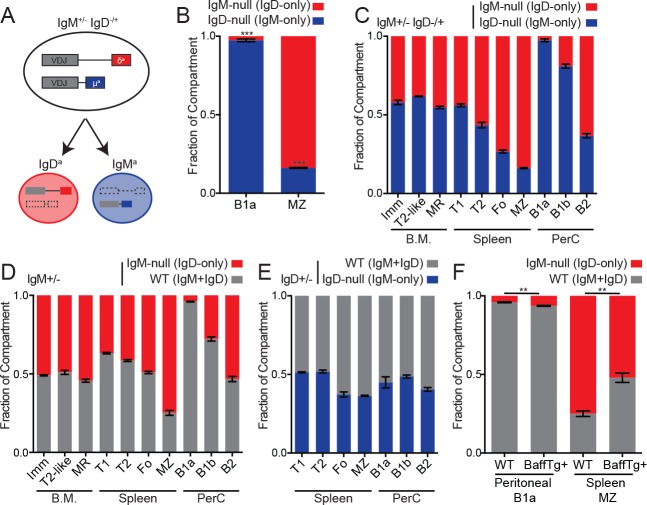
Cell-intrinsic skewing of B cell development by IgM and IgD BCRs.(A) Allelic exclusion leads to a 1:1 mixture of IgM-only and IgD-only B cells in IgM+/− IgD−/+ mice. (B) Proportion of peritoneal B1a (CD19+CD5+CD23-) and splenic MZ (B220+CD21hiCD23lo) B cells originating from each Ig locus in IgM+/− IgD−/+ mice. (C) Relative competition between IgM+ and IgD+ B cells in IgM+/− IgD−/+ mice was calculated for bone marrow, splenic, and peritoneal B cell compartments. Results include data from (B) for reference. Immature (CD23-CD93+); T2-like (CD23+CD93+); mature recirculating (CD23+CD93-); T1 (CD93+CD23-); T2/3 (CD93+CD23+); Fo (CD93-CD23+); MZ (CD21hiCD23lo); B1a (CD5+CD23-); B1b (CD5-CD23-); B2 (CD5-CD23+). (D) Relative competition between WT (IgMb+) and IgM-null (IgDa+) B cells in IgM+/− mice was determined as in (C). (E) Relative competition between WT (IgMb+) and IgD-null (IgMa+) B cells in IgD+/− mice was determined for splenic and peritoneal compartments as described in (C). (F) Competition in peritoneal B1a and splenic MZ compartments in IgM+/− mice with or without a BAFF overexpression transgene. Results include data from (D) for reference. For (B) and (C), n = 3–5 mice were analyzed. For (D), n = 3–8 mice were analyzed. For (E), n = 5 mice were analyzed. For (F), n = 4–5 mice of each genotype were analyzed. Welch’s t test was used to calculate p values, and mean ±SEM is displayed. **p<0.01, ***p<0.001.10.7554/eLife.35074.021Figure 4—source data 1.Numerical data corresponding to competition between IgM-only, IgD-only and WT B cells in Figure 4B–F, and in Figure 4—figure supplement 1B-DNumerical data corresponding to competition between IgM-only, IgD-only and WT B cells inFigures 4B-F.Numerical data corresponding to splenic and peritoneal B cell compartment sizes in Figure 4—figure supplement 1B–C. Numerical data corresponding to competition between IgHa and IgHb B cells in Figure 4—figure supplement 1D.10.7554/eLife.35074.022Figure 4—source data 2.Numerical data corresponding to competition between IgM-only, IgD-only and WT B cells in Figure 4B–E.10.7554/eLife.35074.023Figure 4—source data 3.Numerical data corresponding to competition between IgD-only and WT B cells in Figure 4F.